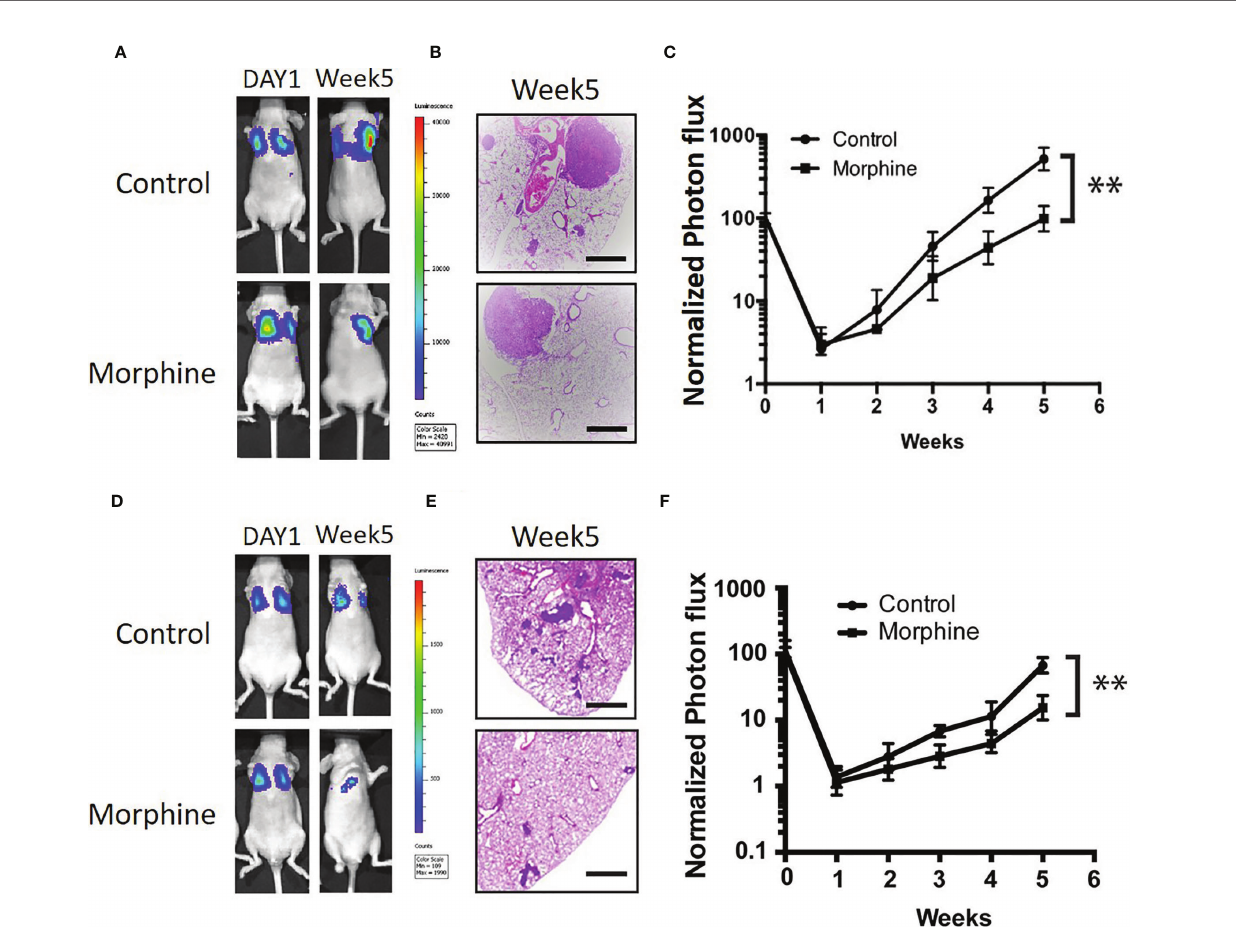
FIGURE 5 | Morphine inhibits lung tumorigenicity of Hep3B/HepG2 cells in vivo . (A) Luminescence of nude mice that were tail vein injected with Hep3B cells at the initiation time point and 5 weeks after. (B) Lung sections of nude mice that were tail vein injected with Hep3B cells for H&E staining (scaled bar length = 500 m m). (C) Relative quanti fi cation of luminescence of nude mice that were tail vein injected with Hep3B cells was showed. (D) Luminescence of nude mice that were tail vein injected with HepG2 cells at the initiation time point and 5 weeks after. (E) Lung sections of nude mice that were tail vein injected with HepG2 cells for H&E staining (scaled bar length = 500 m m). (F) Relative quanti fi cation of luminescence of nude mice that were tail vein injected with HepG2 cells was showed. Data were shown as mean ± SD. n=9 per group. ** P <